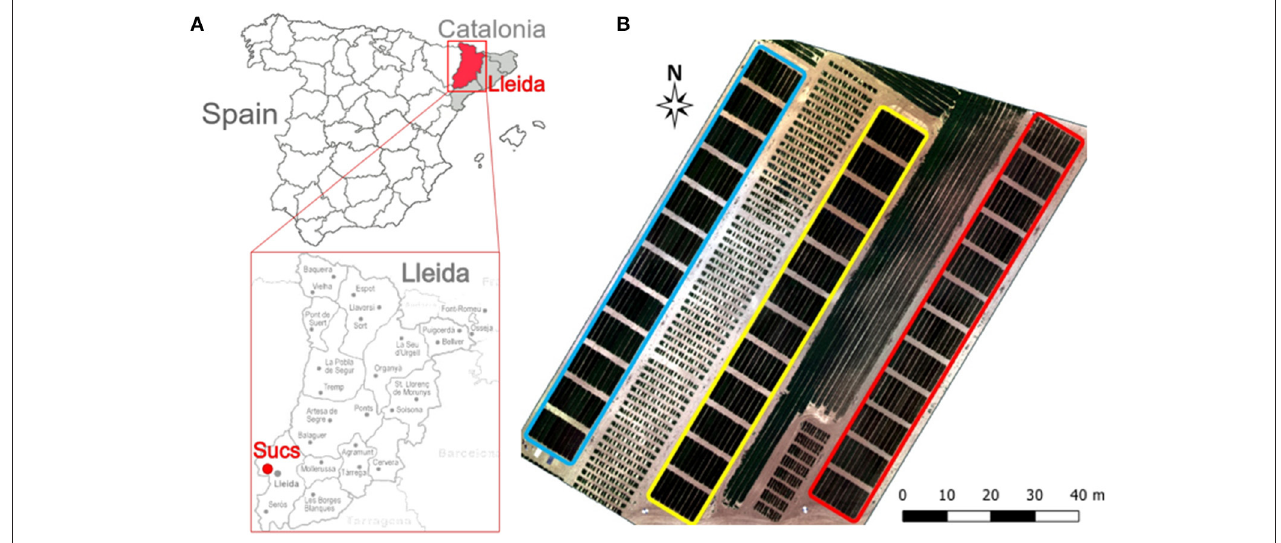
FIGURE 1 | (A) Study site location; (B) Layout of the field experiment showing the three irrigation treatments: 100%ETc (blue), 50%ETc (yellow), and rainfed